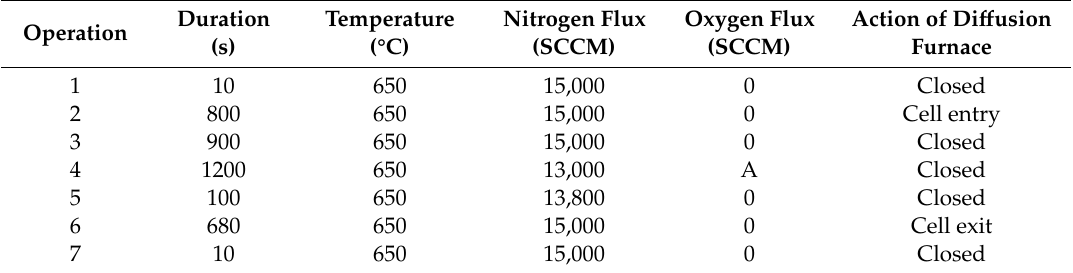
Table 4. The specific operations of thermal oxidation.